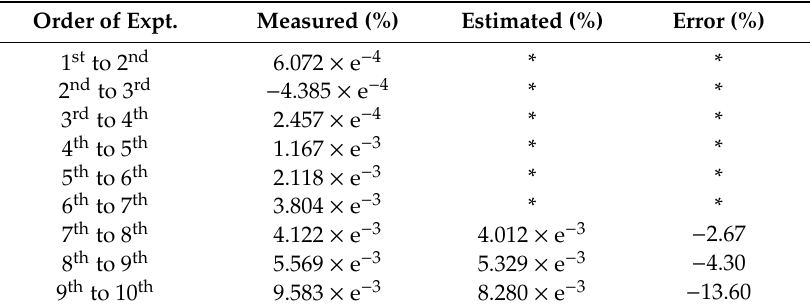
Table 6. List of ζ Jv .